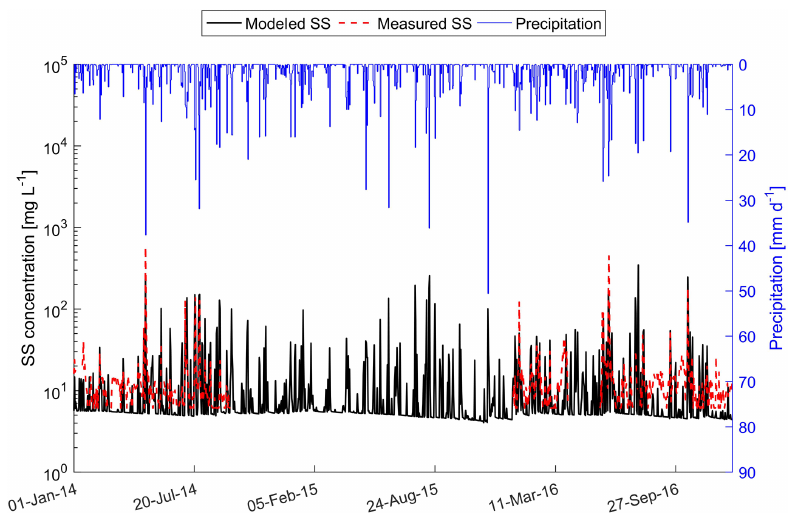
Figure 5. Modeled and measured suspended sediment concentrations used for calibration (year 2014) and validation (year 2016) of the sediment transport model. A data gap exists for the year